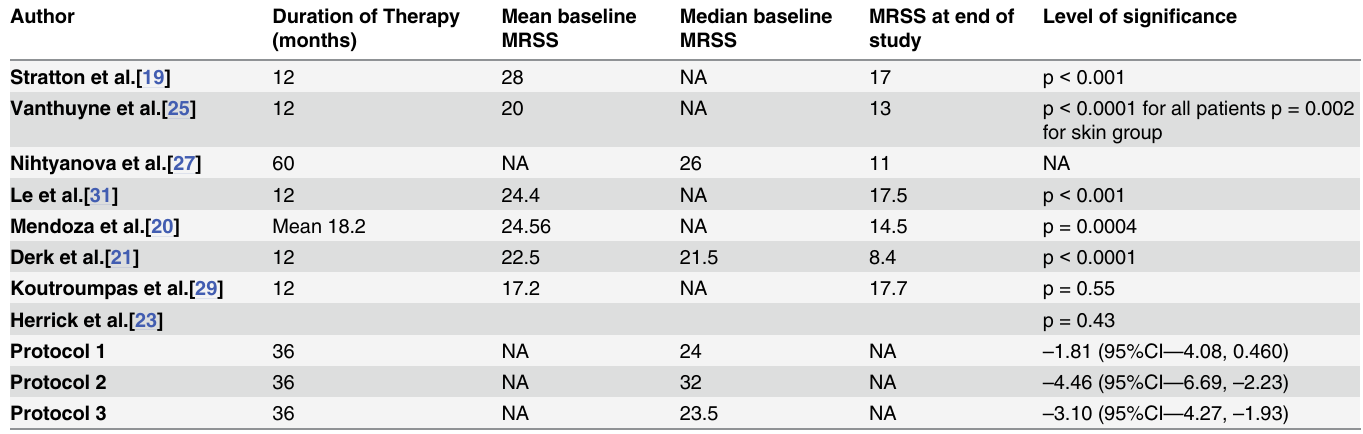
Table 2. Effect of mycophenolate mofetil on modified Rodnan skin